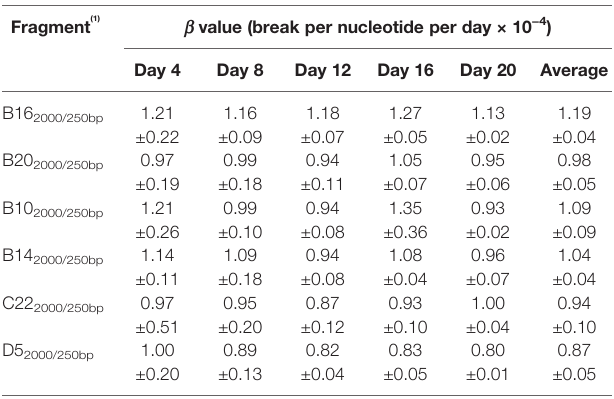
TABLE 2 | Estimated “ b ” values for stored mRNAs of six genes at different aging times. Fragment